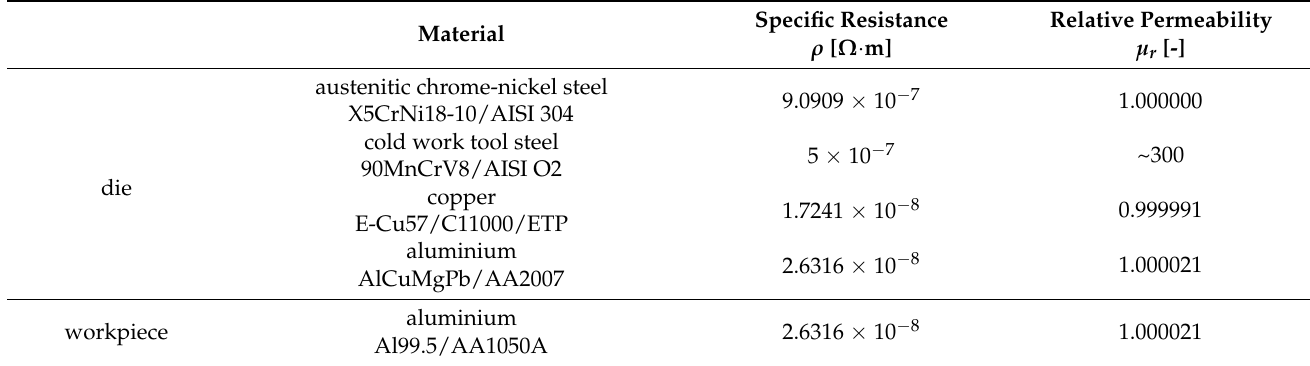
Table 1. Electromagnetic properties of the used die and workpiece materials from the ANSYS